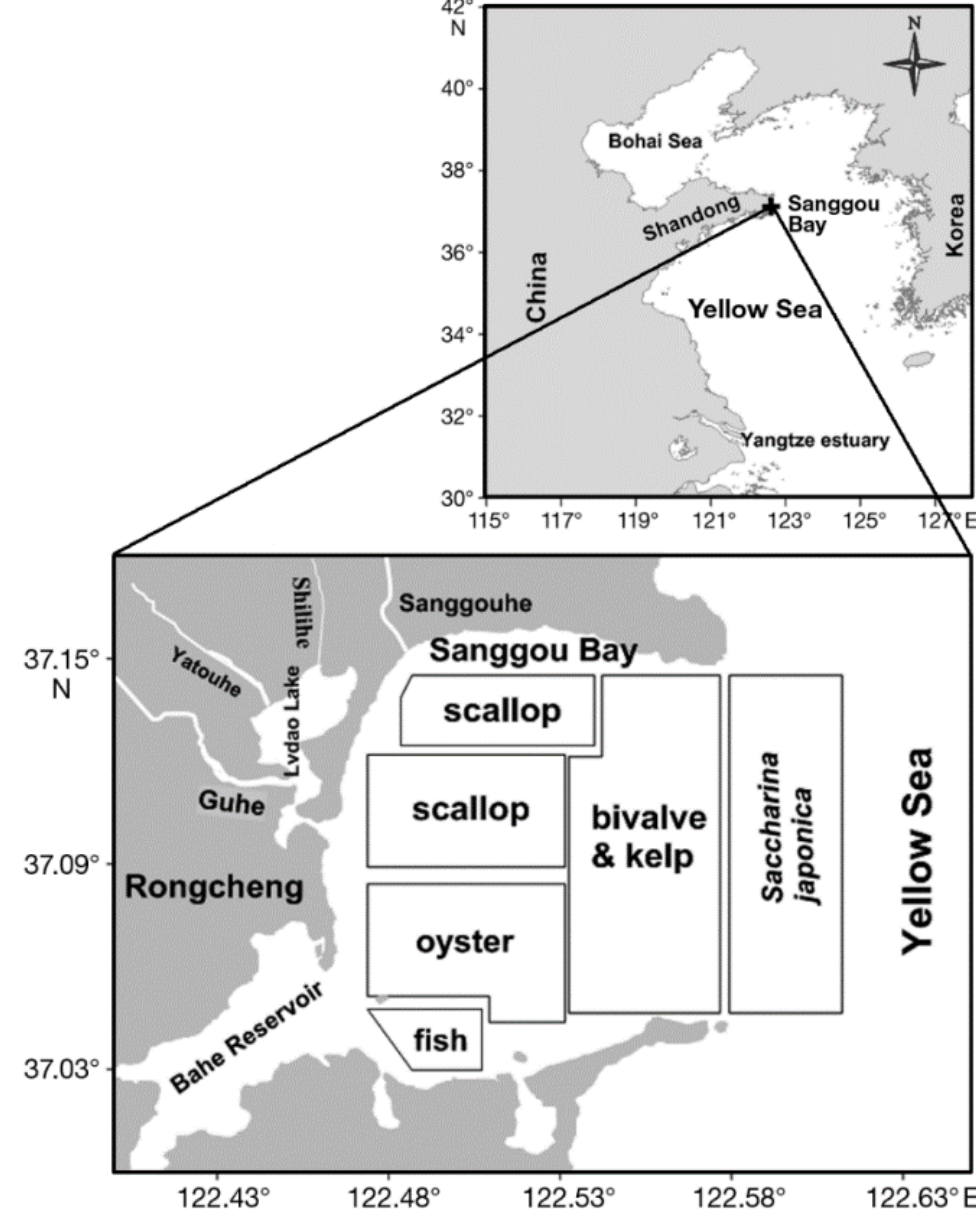
Figure 21. Integrated multi-trophic aquaculture system in Sanggou Bay, China [43].